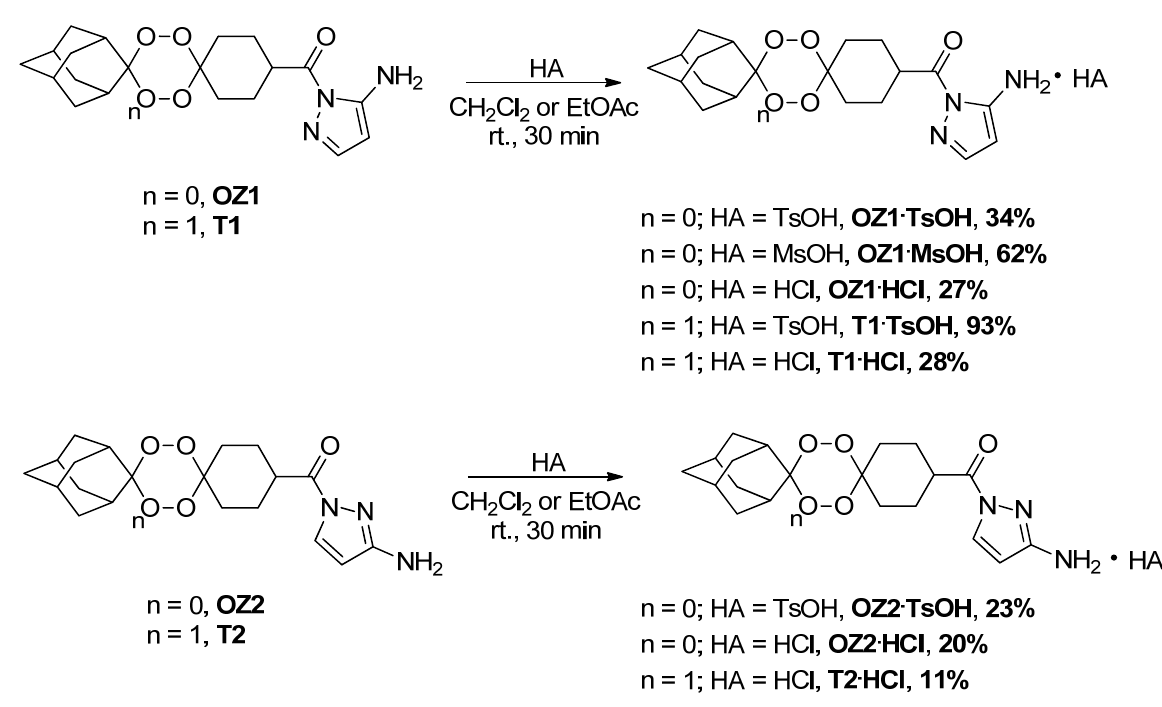
Scheme 3. Preparation of different salt forms from the endoperoxide–pyrazole